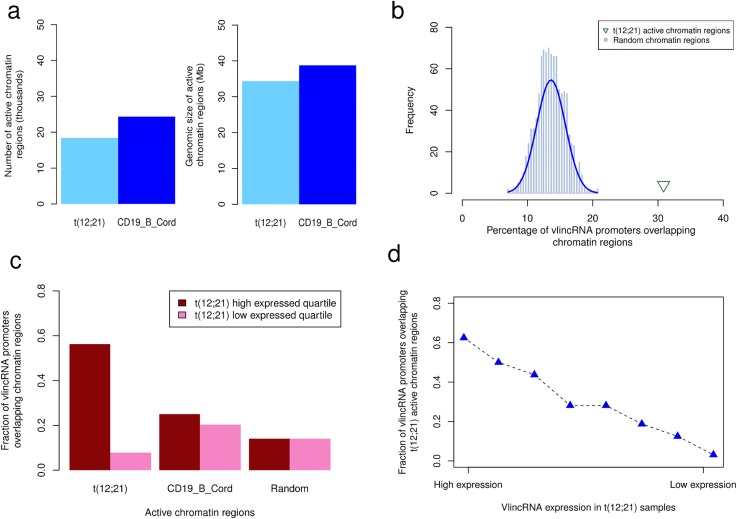
Epigenetic regulation at cALL vlincRNA promoters.(a) Number (left) and genomic size (right) of active chromatin regions in two t(12;21) samples and CD19+ B cord. Active chromatin regions in the t(12;21) samples were generated using ChromHMM on three chromatin marks (H3K4me3, H3K27ac and H3K4me1) and retaining states having the H3K4me3 mark present. Active CD19+ B cord chromatin regions were obtained from the Roadmap Epigenomics Project [14]by keeping states having the H3K4me3 mark present (states 1,2,3,10, and 11) from the 15-state model. (b) Percentage of vlincRNA promoters (n = 256) overlapping active t(12;21) chromatin regions (30.9%; 79 / 256) and random regions (mean 14.06%; 36 / 256). Random regions were generated a thousand times using shuffleBed from bedtools. (c) Percentage of vlincRNA promoters overlapping active t(12;21) chromatin regions, active CD19+ B cord chromatin regions and random regions in the t(12;21) high and low expressed vlincRNA quartiles (Q1 and Q4, n = 64). (d) Fraction of vlincRNA promoters overlapping active t(12;21) chromatin regions sorted by t(12;21) vlincRNA expression (8 bins of 32 promoters). HCB-B: CD19+CD10+ pre-B cells isolated from human cord blood.